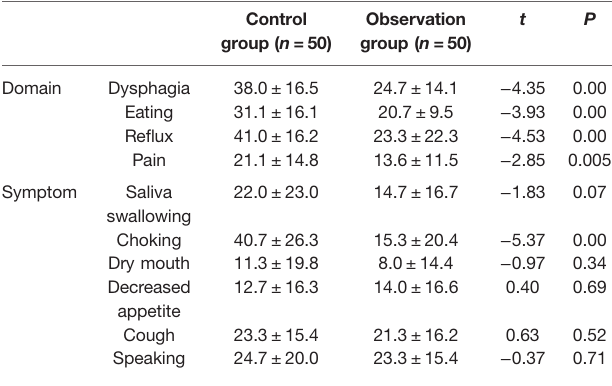
TABLE 6 | Comparison of scores of quality of life (QLQ-OES18) of patients with esophageal cancer in two groups at return visit in the hospital 1 month after